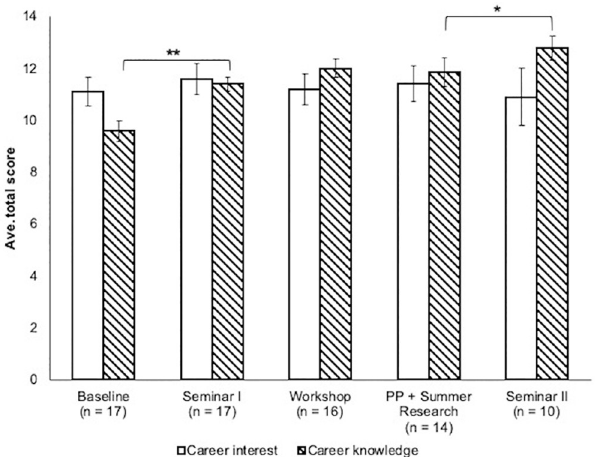
Fig 4. Average CI and CK scores after DIVAS pipeline interventions for the three years of the project. Error bars represent standard error of the mean. PP = pair programming. A paired t-test was used to compare means between subsequent interventions for each score type. � , p < 0.05; �� , p < 0.01.